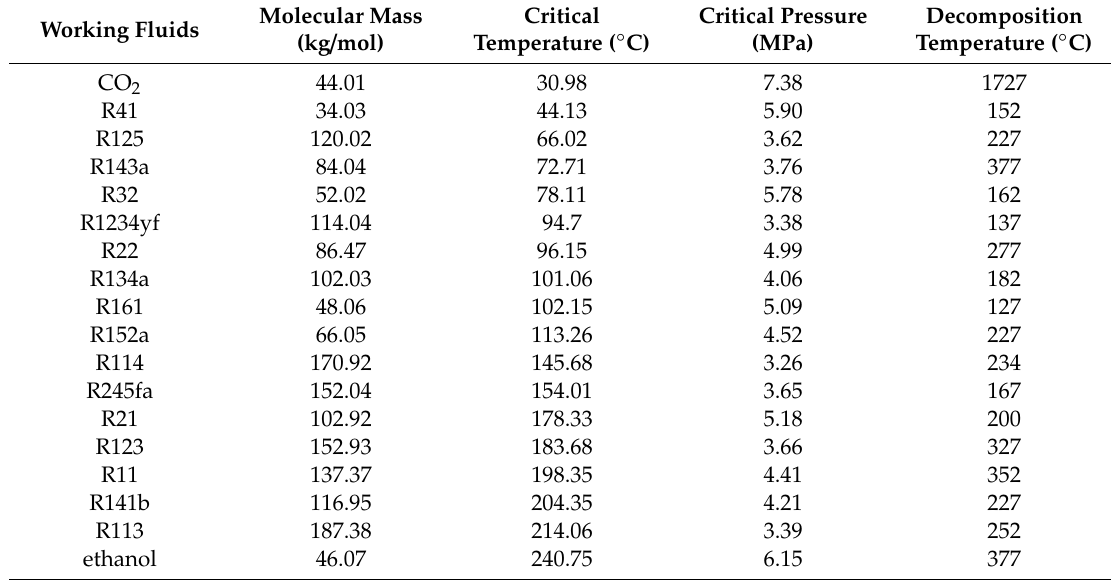
Table 7. Thermophysical parameters of di ff erent working